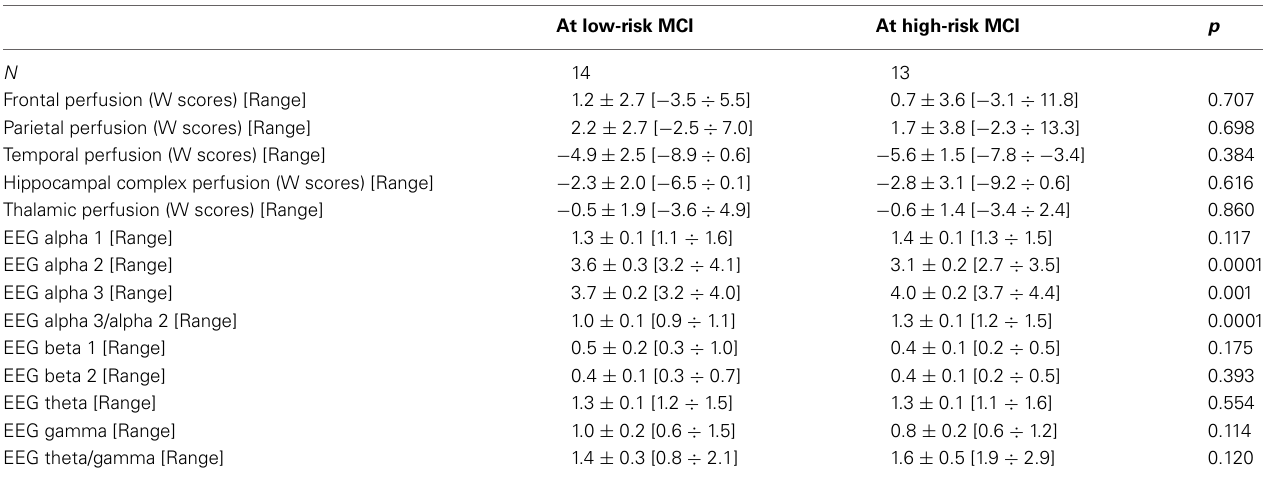
Table 2 | Brain perfusion and EEG rhythms in MCI patients by risk to develop AD At low-risk MCI At high-risk MCI